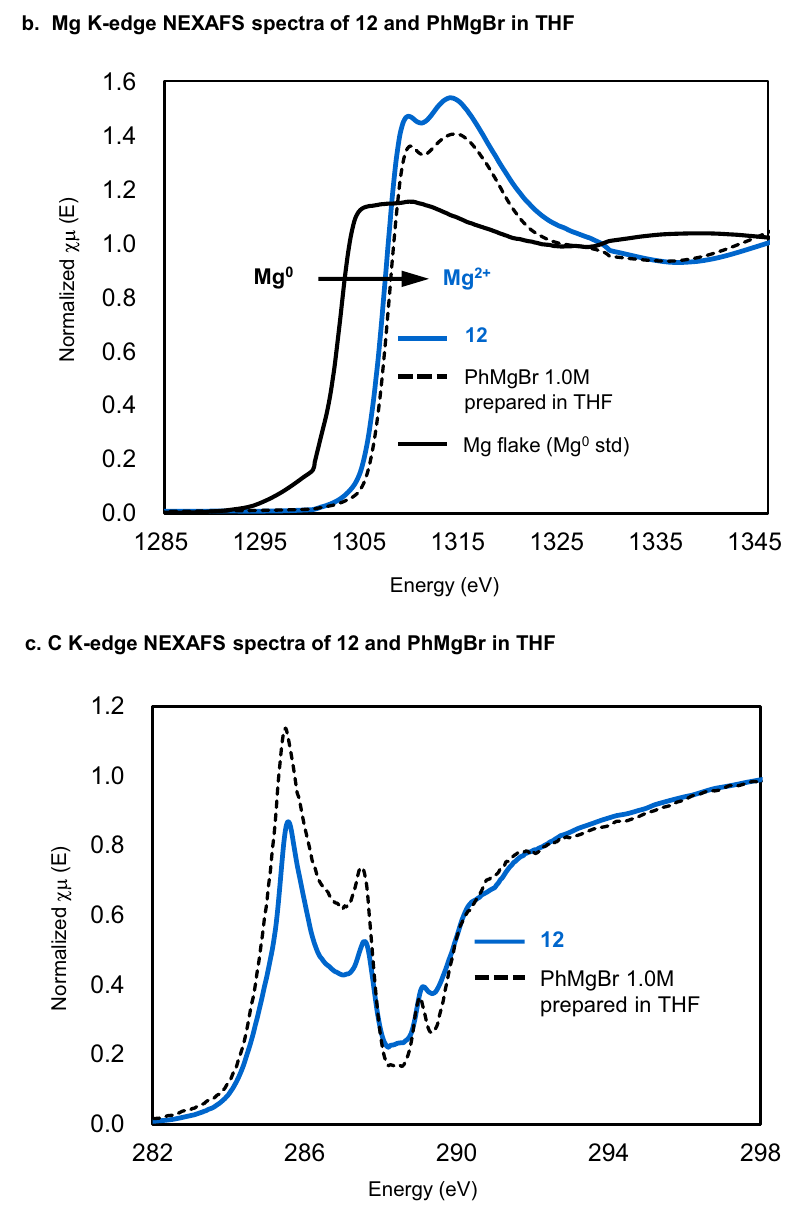
Fig. 5 NEXAFS analysis of a magnesium-based carbon nucleophile under mechanochemical conditions. a Preparation of a sample of magnesium-based carbon nucleophile 12 under mechanochemical conditions. b Mg K-edge NEXAFS spectra of mechanochemically prepared 12 , PhMgBr prepared in solution, and a magnesium fl ake of a Mg 0 standard. c C K-edge NEXAFS spectra of mechanochemically prepared 12 and PhMgBr prepared in